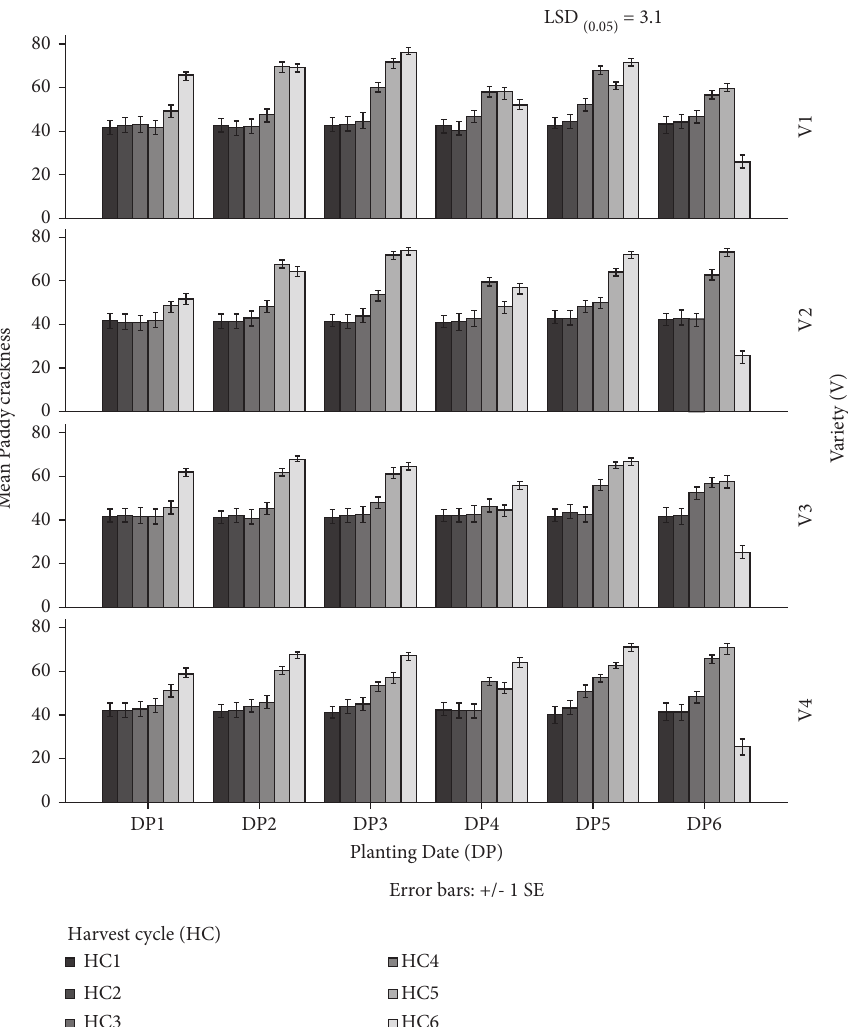
Figure 1: Effect of planting date, harvest cycle, and variety on mean paddy cracking in the Northern Savanna Agroecological Zone of Ghana. Bars represent the SEM. DP1 � first planting, DP2 � second planting, DP3 � third planting, DP4 � fourth planting, DP5 � fifth planting, DP6 � sixth planting, V1 � Agra, V2 � Gbewaa, V3 � Exbaika, V4 � Perfume Irrigated, HC1 � first harvest, HC2 � second harvest, HC3 � third harvest, HC4 � fourth harvest, HC5 � fifth harvest, and HC6 � sixth